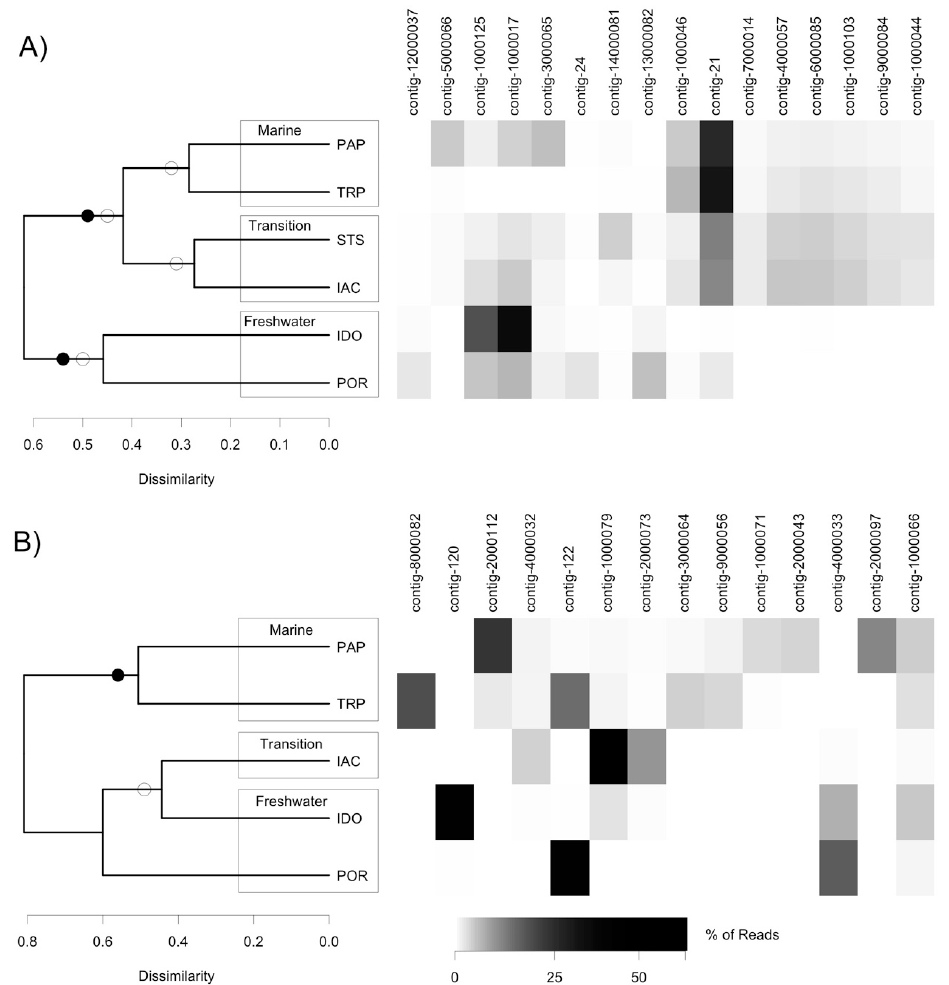
Figure 4. Samples clustered using unweighted UniFrac distances on virus community, and relative abundance of contigs in sampling sites (rarefied to 12,000 reads per sample for DNA viruses and 2000 reads for RNA viruses); ( A ) DNA virus community; ( B ) RNA virus community. Open circles indicate nodes which also appear in clustering using a Morisita-Horn index based on OTUs. Closed circles indicate nodes which also appear in a COMMET (Compare Multiple Metagenomes) analysis (Jaccard index) of raw reads. For COMMET analysis, reads were rarefied to 35,500 for DNA viruses and 7900 for RNA viruses. Note that no RNA viruses were detected at the St-Siméon site (STS).